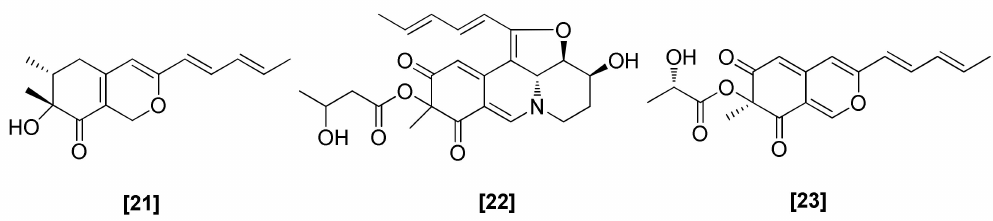
Figure 6. Structures of antifungal azaphilones isolated from T. harzianum: [21] harziphilone, [22] fleephilone, [23]